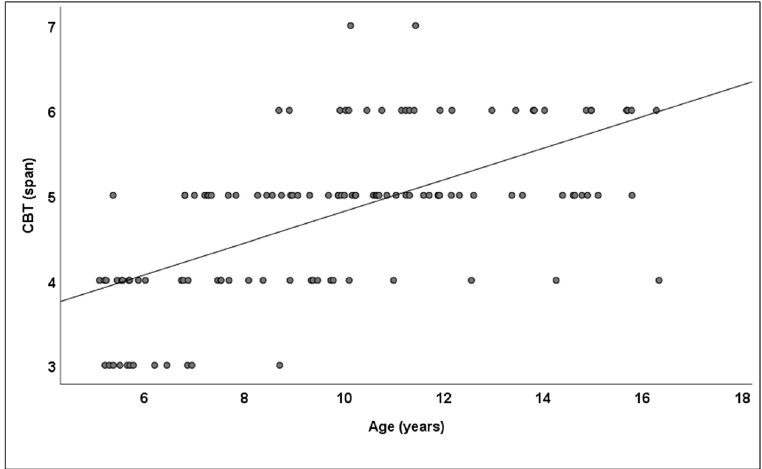
Figure 3. Visuospatial working memory with respect to age in the entire study group.